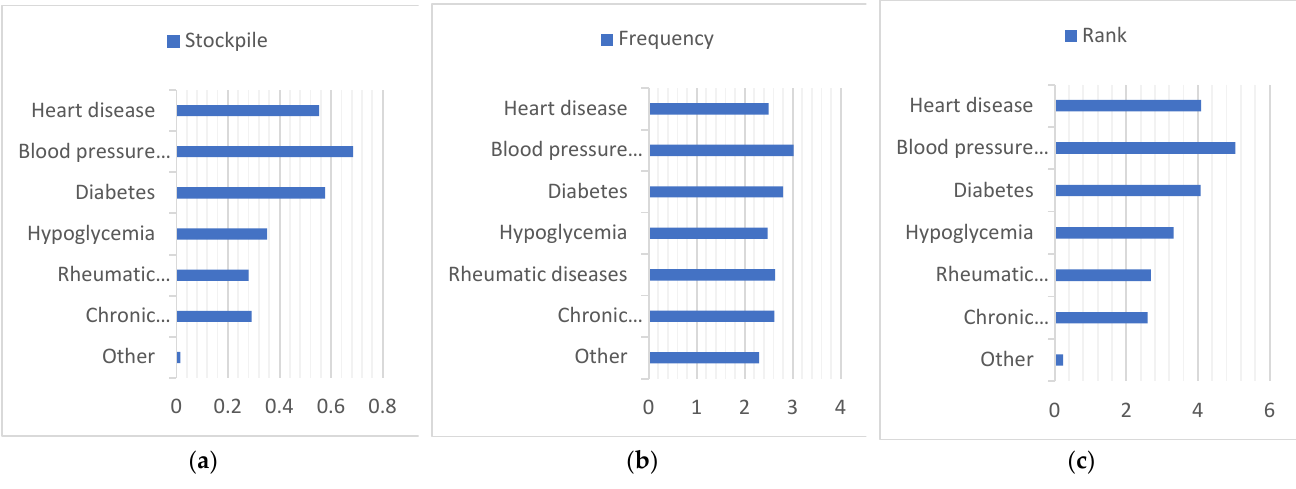
Table 7. Model Summary a .